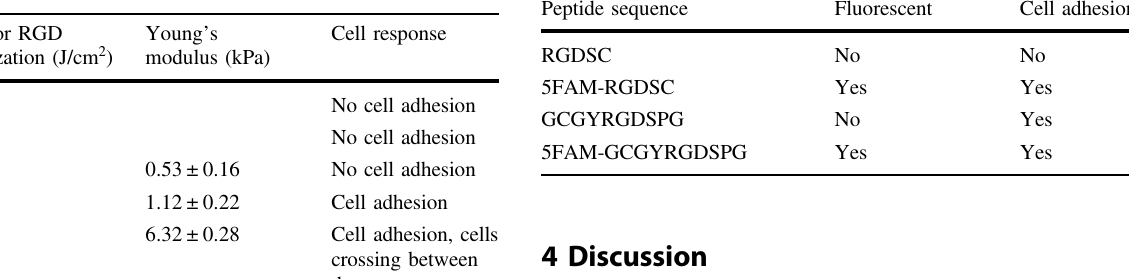
Table 1 The cell response varied for different UV dosages tested for the RGD functionalization. The HA-am hydrogels were formed using a constant UV dose of 4.6 J/cm 2 UV dose for RGD functionalization (J/cm 2 )